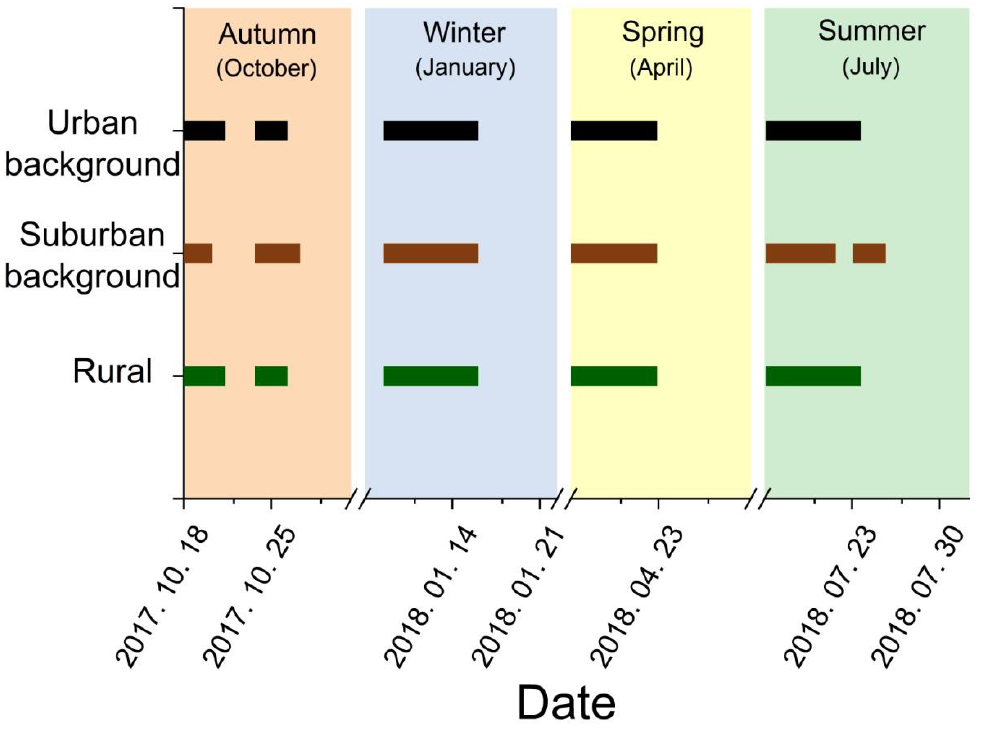
Figure 2. Sampling campaign intervals of aerosol collection at the different sites in each season.